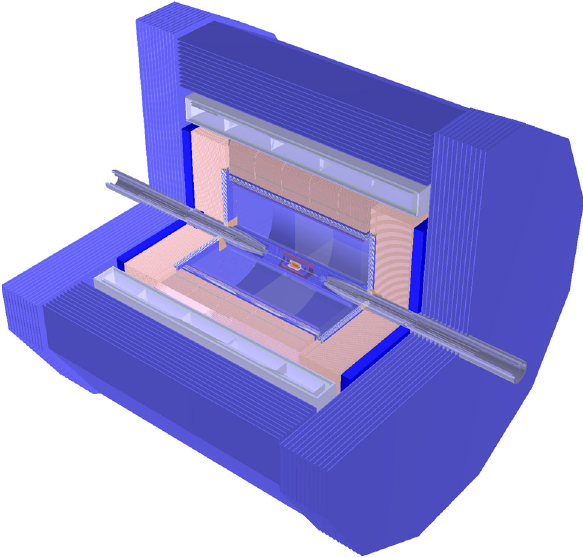
Fig. 2 The CEPC baseline detector. From inner to outer, the detector is composed of a silicon pixel vertex detector, a silicon inner tracker, a TPC, a silicon external tracker, an ECAL, an HCAL, a solenoid of 3 Tesla and a return yoke embedded with a muon detector. In the forward regions, five pairs of silicon tracking disks are installed to enlarge the tracking